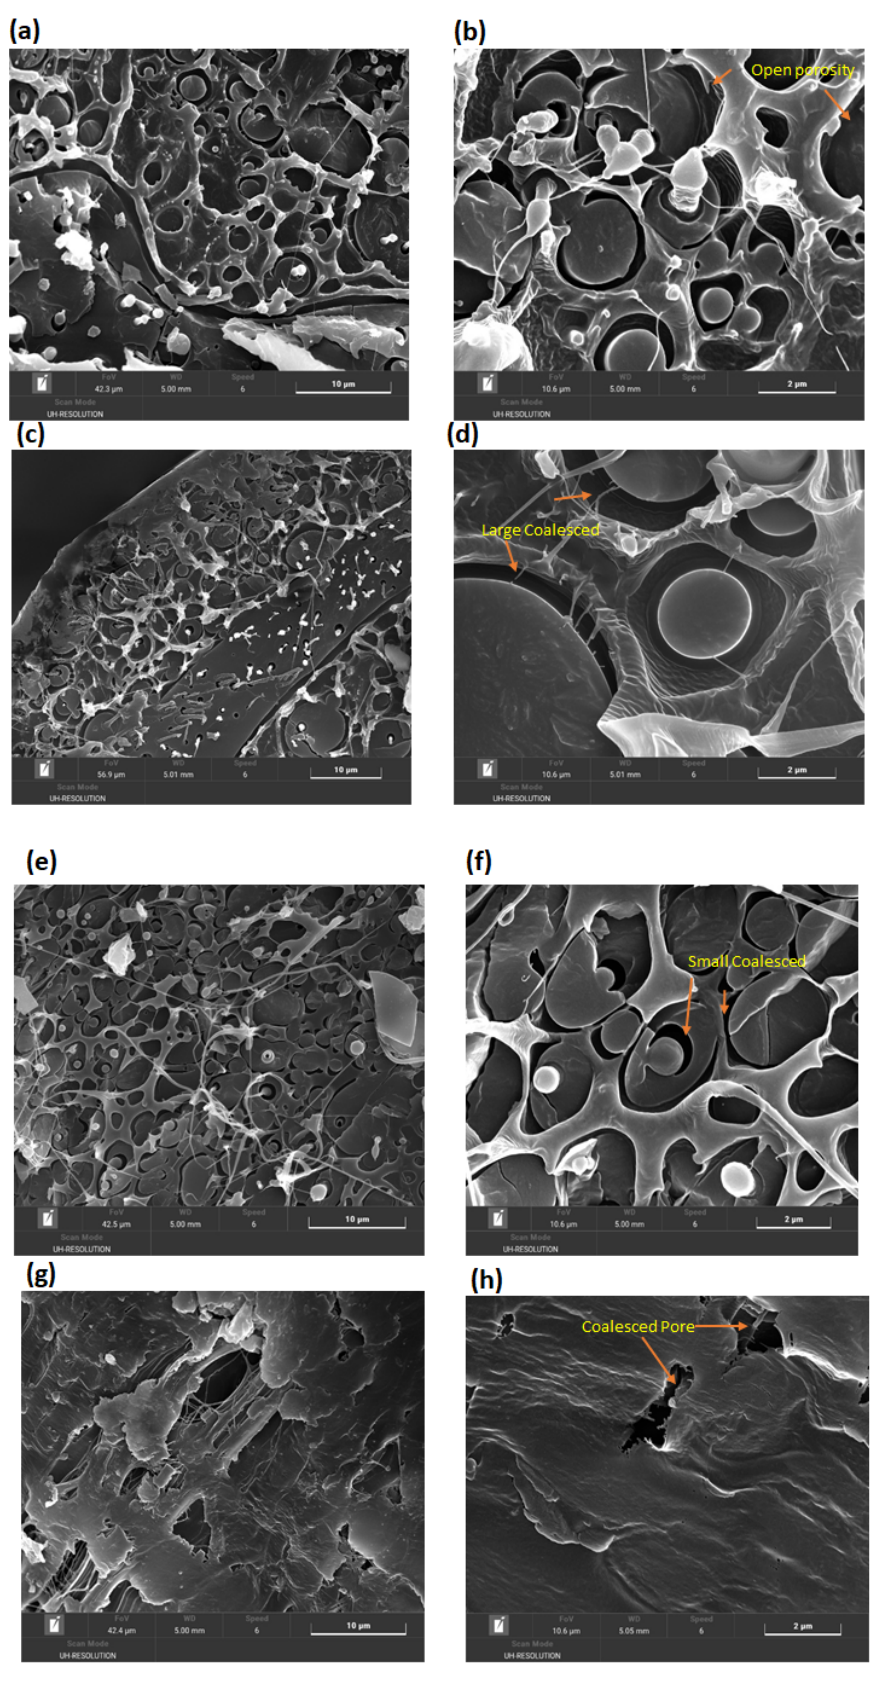
Figure 4. Morphology of LLDPE/MP fibres for different dwell times: zero ( a , b ), 6 ( c , d ), 8 ( e , f ), and 10 min ( g , h ).